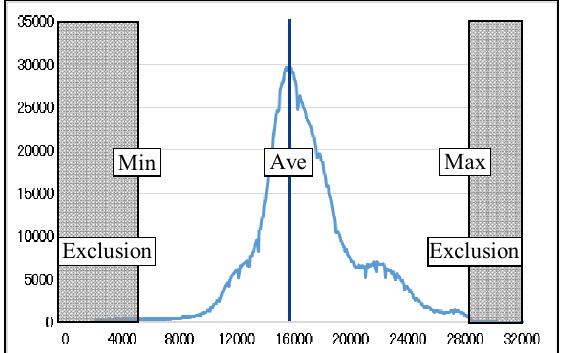
Figure 10. Intensity distribution chart